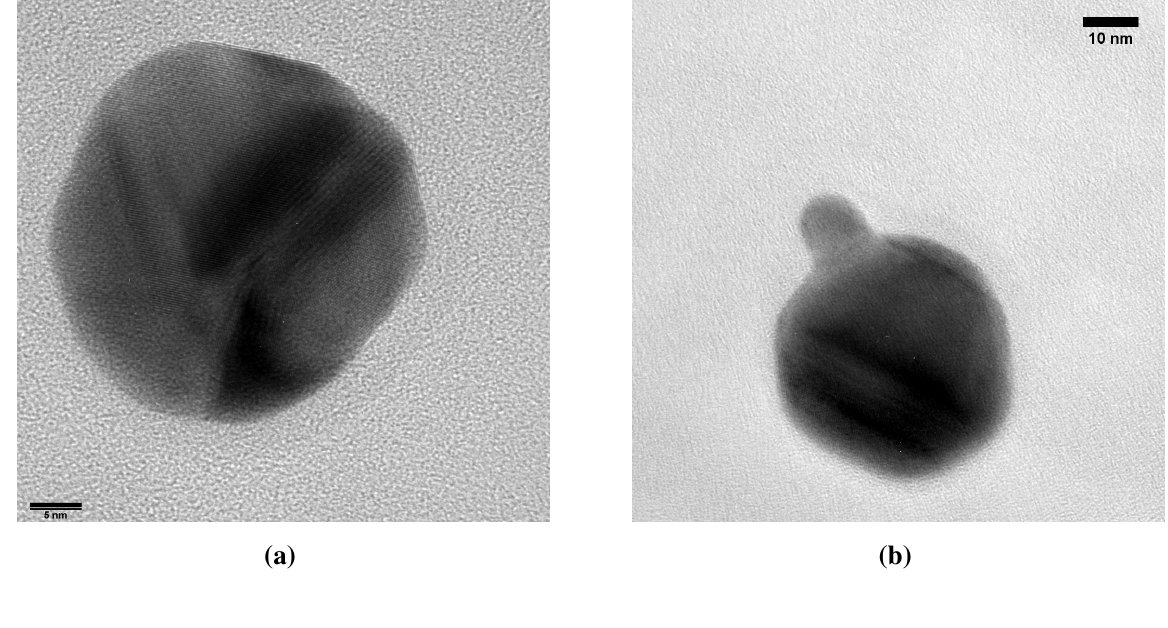
Figure 8. TEM micrographs of Ag-on-Au nanoparticles, ( a ) 5-nm scale bar; ( b ) 10-nm scale bar.